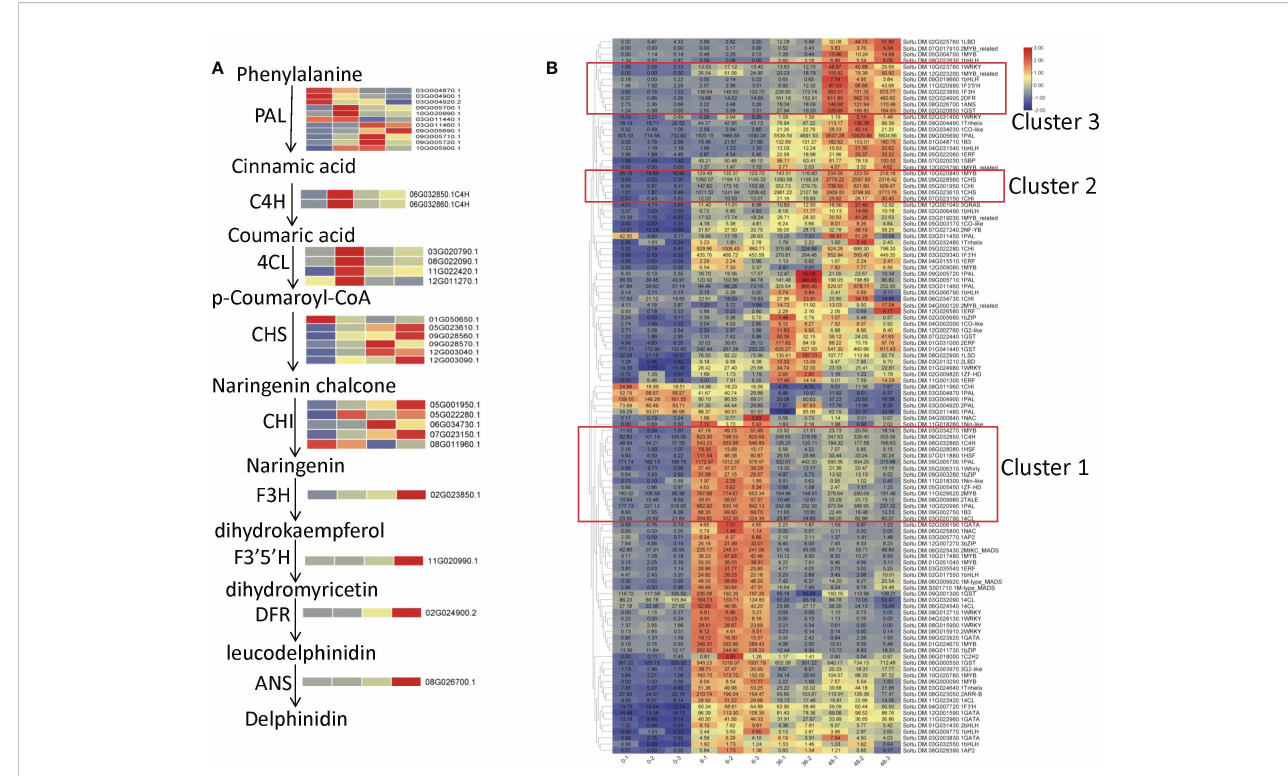
FIGURE 4 Co-expression analysis of structural genes and transcription factors in DEGs. (A) Anthocyanin biosynthesis pathway. (B) Co-expression cluster analysis of structural genes and transcription factors. The red boxes mark transcription factors that have a high correlation with the expression of key structural